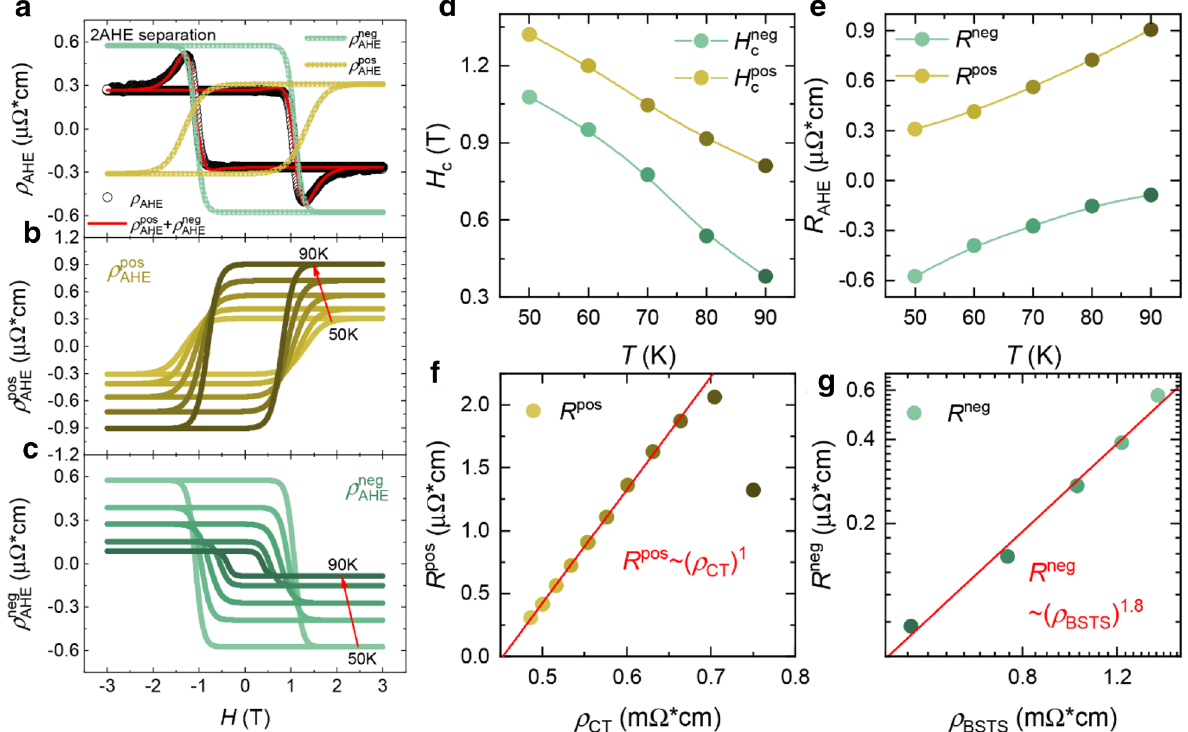
50 K. b, c = pos ( neg ) c ) ( d ) and the amplitude of anomalous